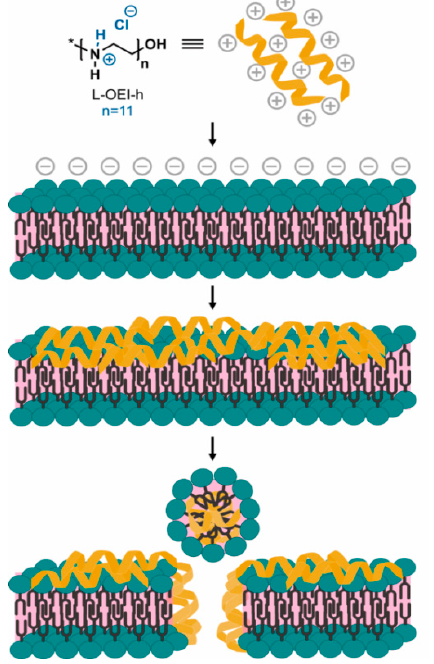
Figure 6. Hypothetical mechanism of action of L-OEI-h (model II) towards bacterial cell mem- branes. The accumulation of the polycationic oligomer at the membrane surface, due to electrostatic interactions, results in an oligomer threshold concentration capable of cell disruption and lysis.